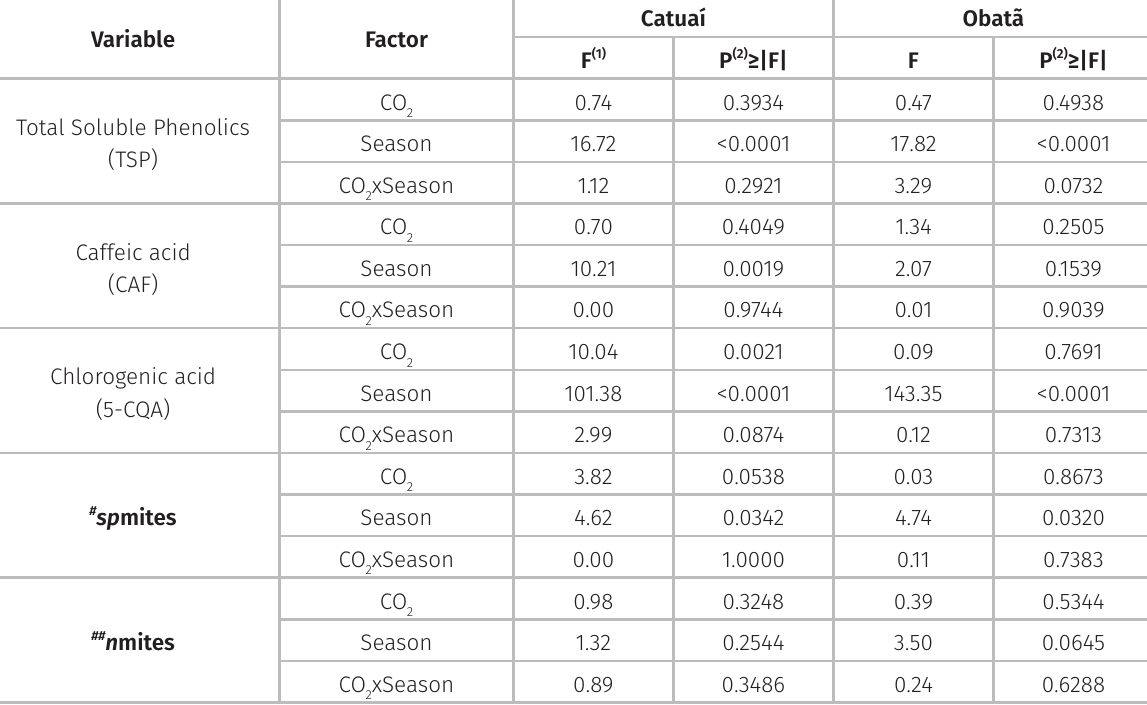
] (elevated/ambient), in two seasons (dry/rainy) under factorial 2